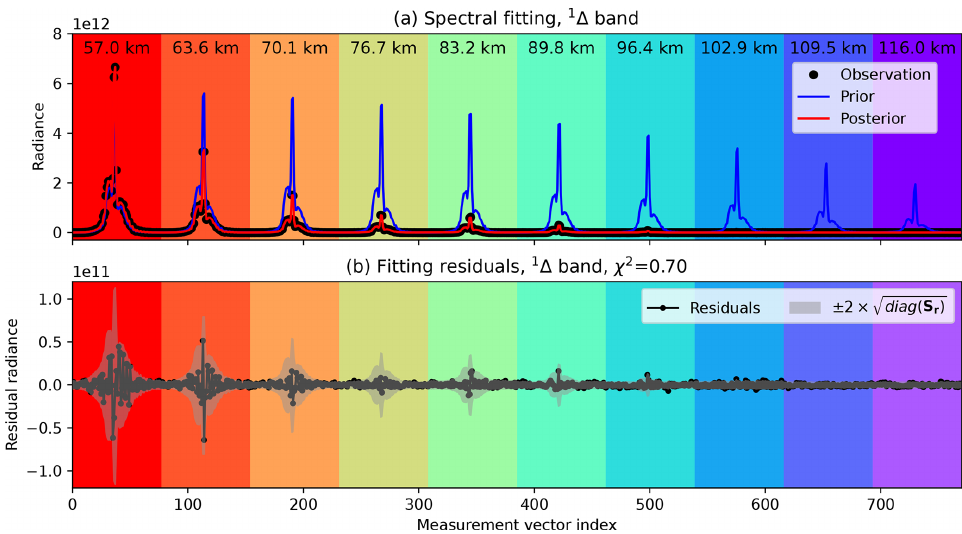
Figure 4. Similar to Fig. 2 but using 10 limb views in an MLT vertical sounding.